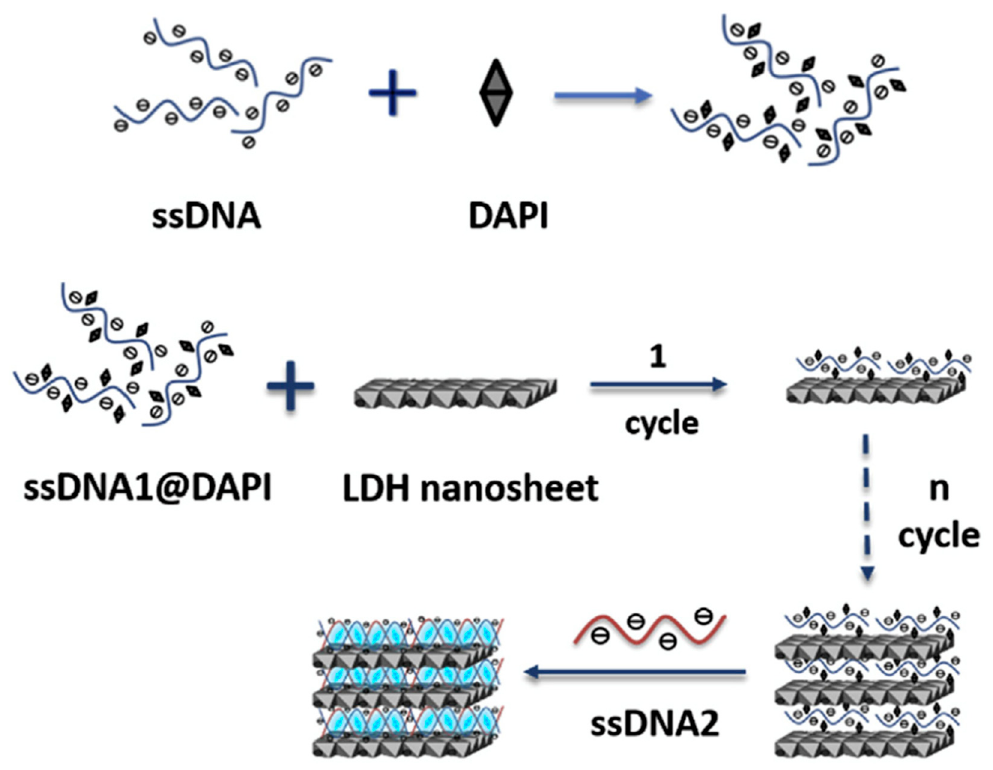
Figure 11. Scheme of the assembly of ssDNA blending into DAPI / LDH ultrathin nanosheets. Figure readapted from Ref. [177], with permission from Elsevier.